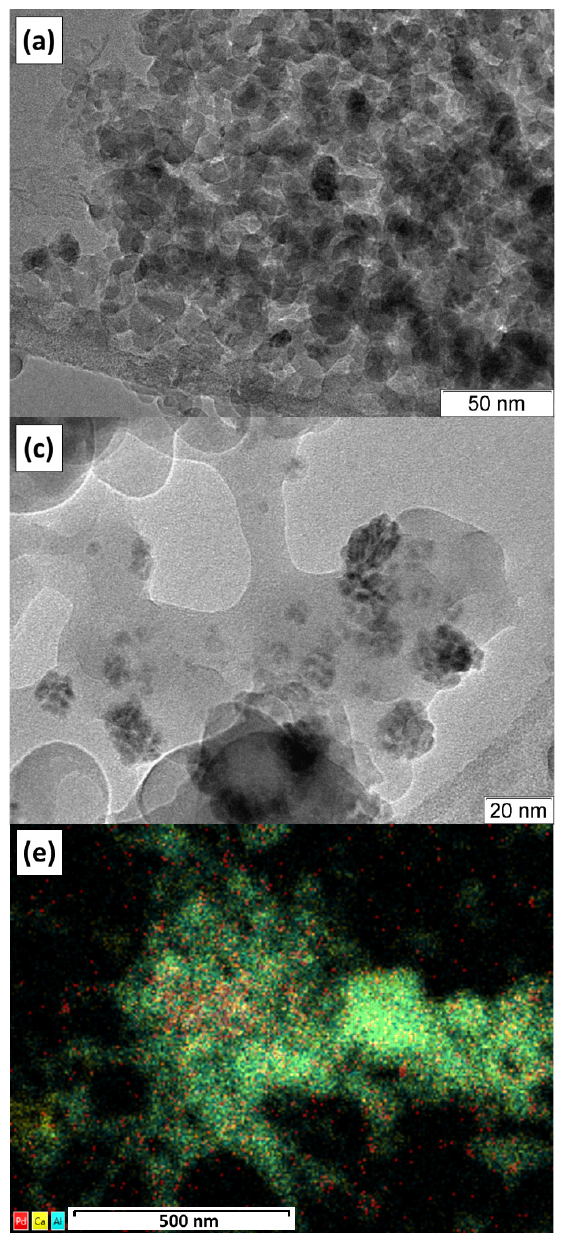
Figure 2. HR TEM images after minimal exposure to an electron beam ( a , b ) and after exposure to the electron beam ( c , d ), as well as elemental mapping ( e , f ), for the Pd-containing C12A7 samples: Pd@C12A7 ( a , c , e ); Pd/C12A7 ( b , d , f ).